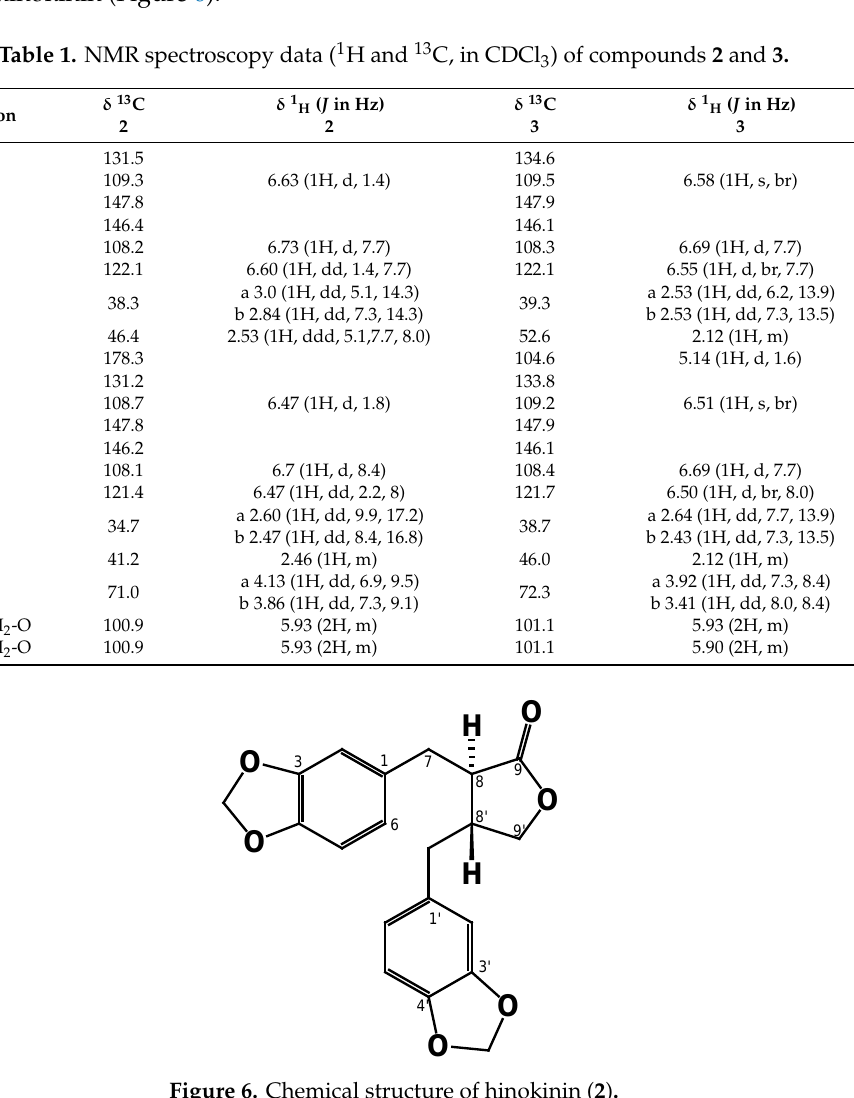
Figure 6. Chemical structure of hinokinin ( 2 ) .